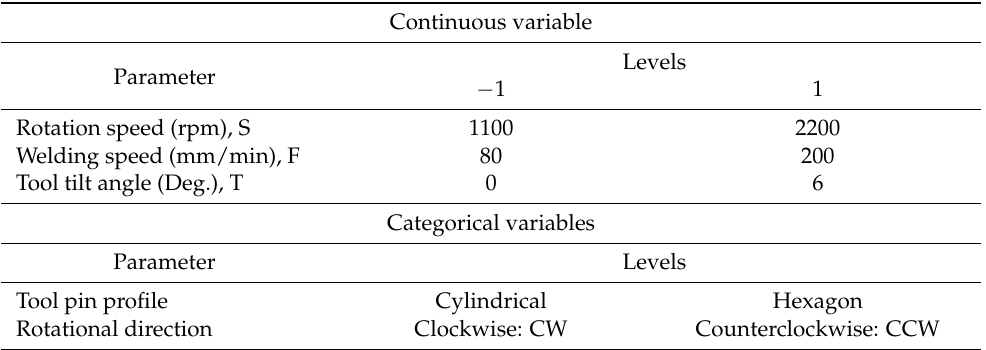
Table 4. Parameters in the